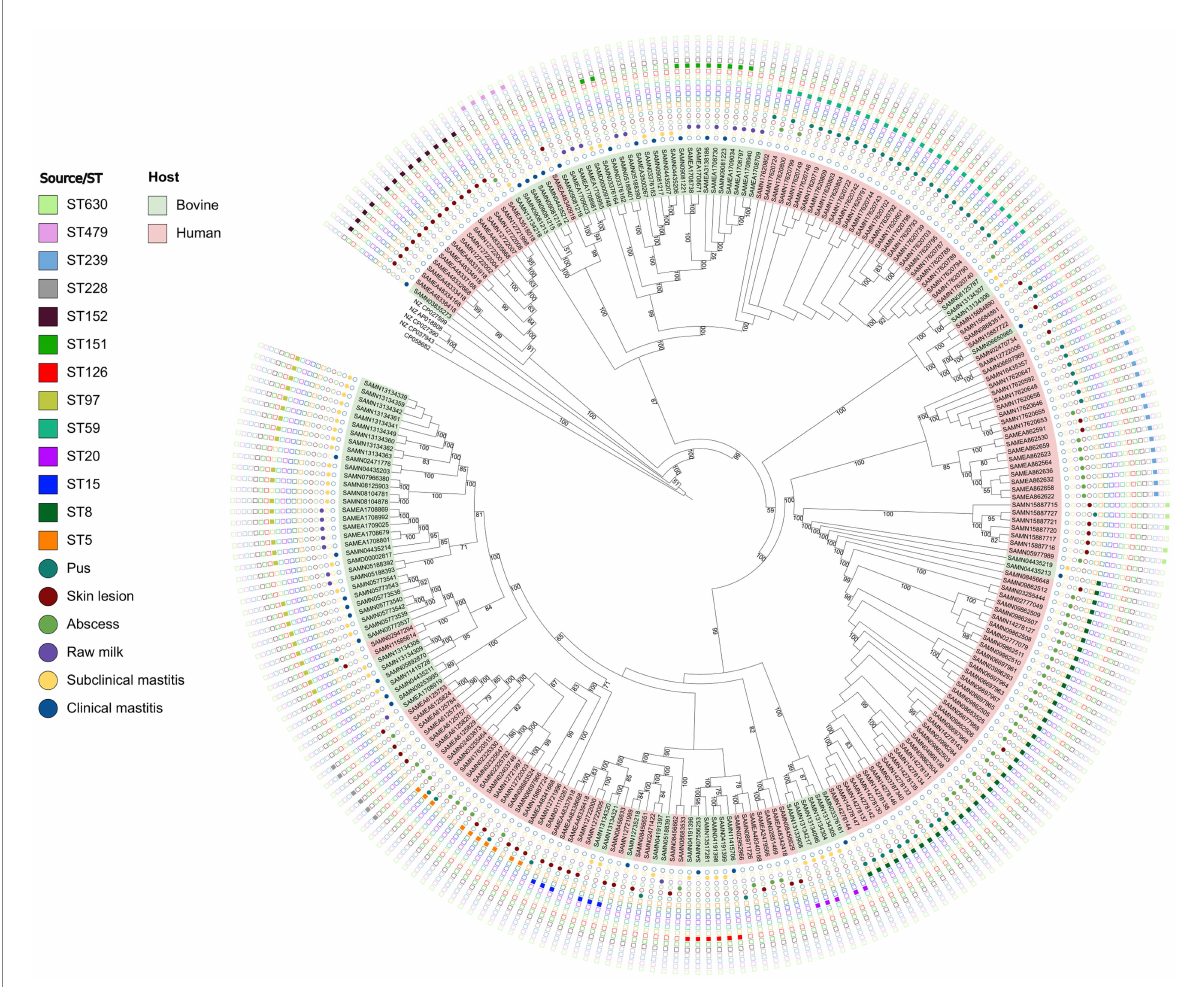
FIGURE 5 Phylogenomic tree based on 248 genes shared across all analyzed Staphylococcus aureus isolated from bovine clinical mastitis and subclinical mastitis cases and raw milk and from human abscesses, skin, and pus